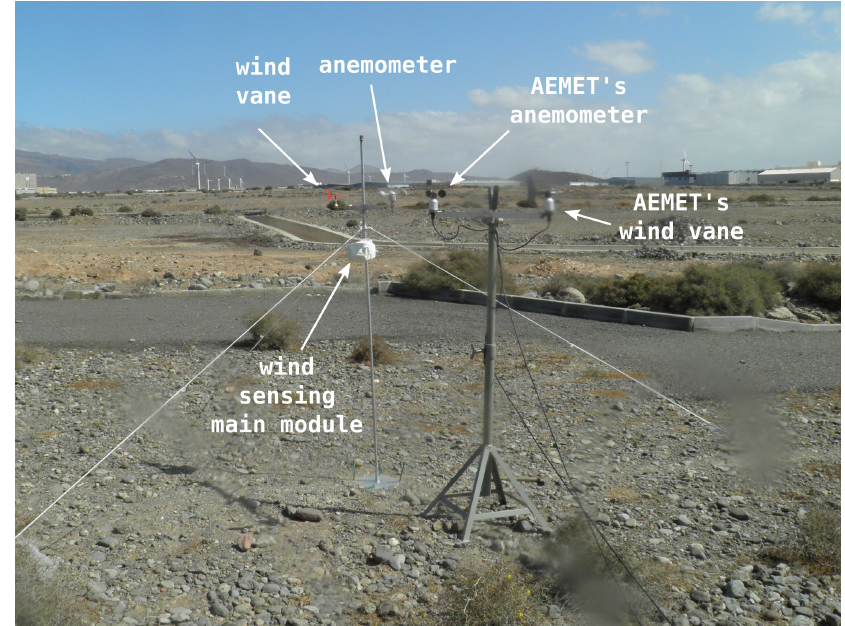
Figure 6. Experimental site during validation